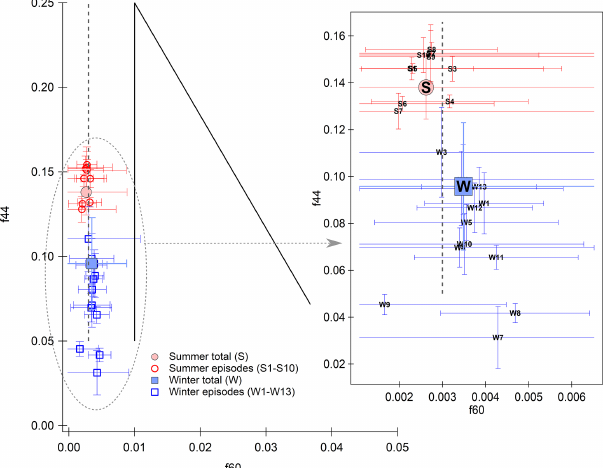
Figure A7. Comparison of organic fragments f 44 and f 60 for the whole campaigns (full markers) and for the specific episodes (empty markers). Bars represent standard deviation and the triangular space area of biomass-burning (BB) influence, and the dashed line shows a limit for a negligible fresh BB influence (Cubison et al., 2011).